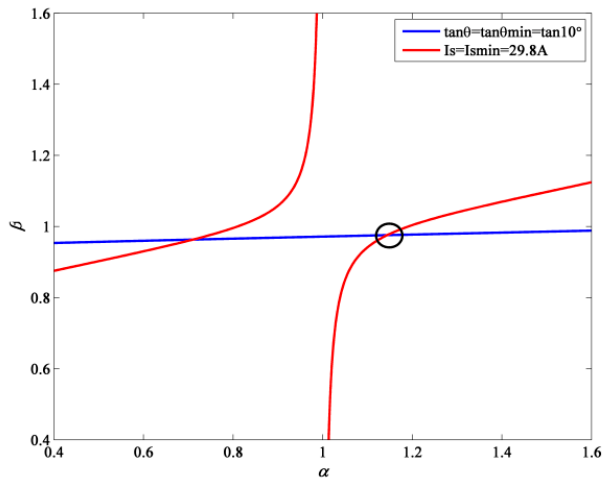
Figure 11. Solutions of Equation (35). U i = 210 V, X s = 7 Ω . The maximum value of R ref is 3.6 Ω , and the minimum value of R ref is 1.8 Ω .